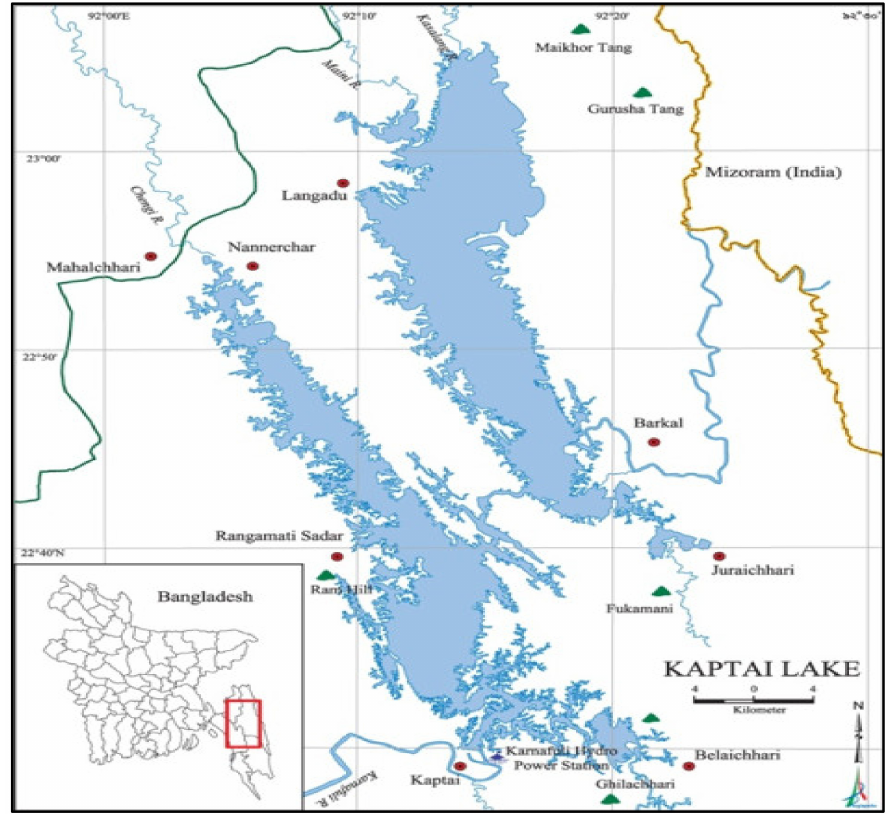
Figure 1. Study area: Location of Rangamati district in Bangladesh, location of Kaptai lake and location of the study sites. Source: